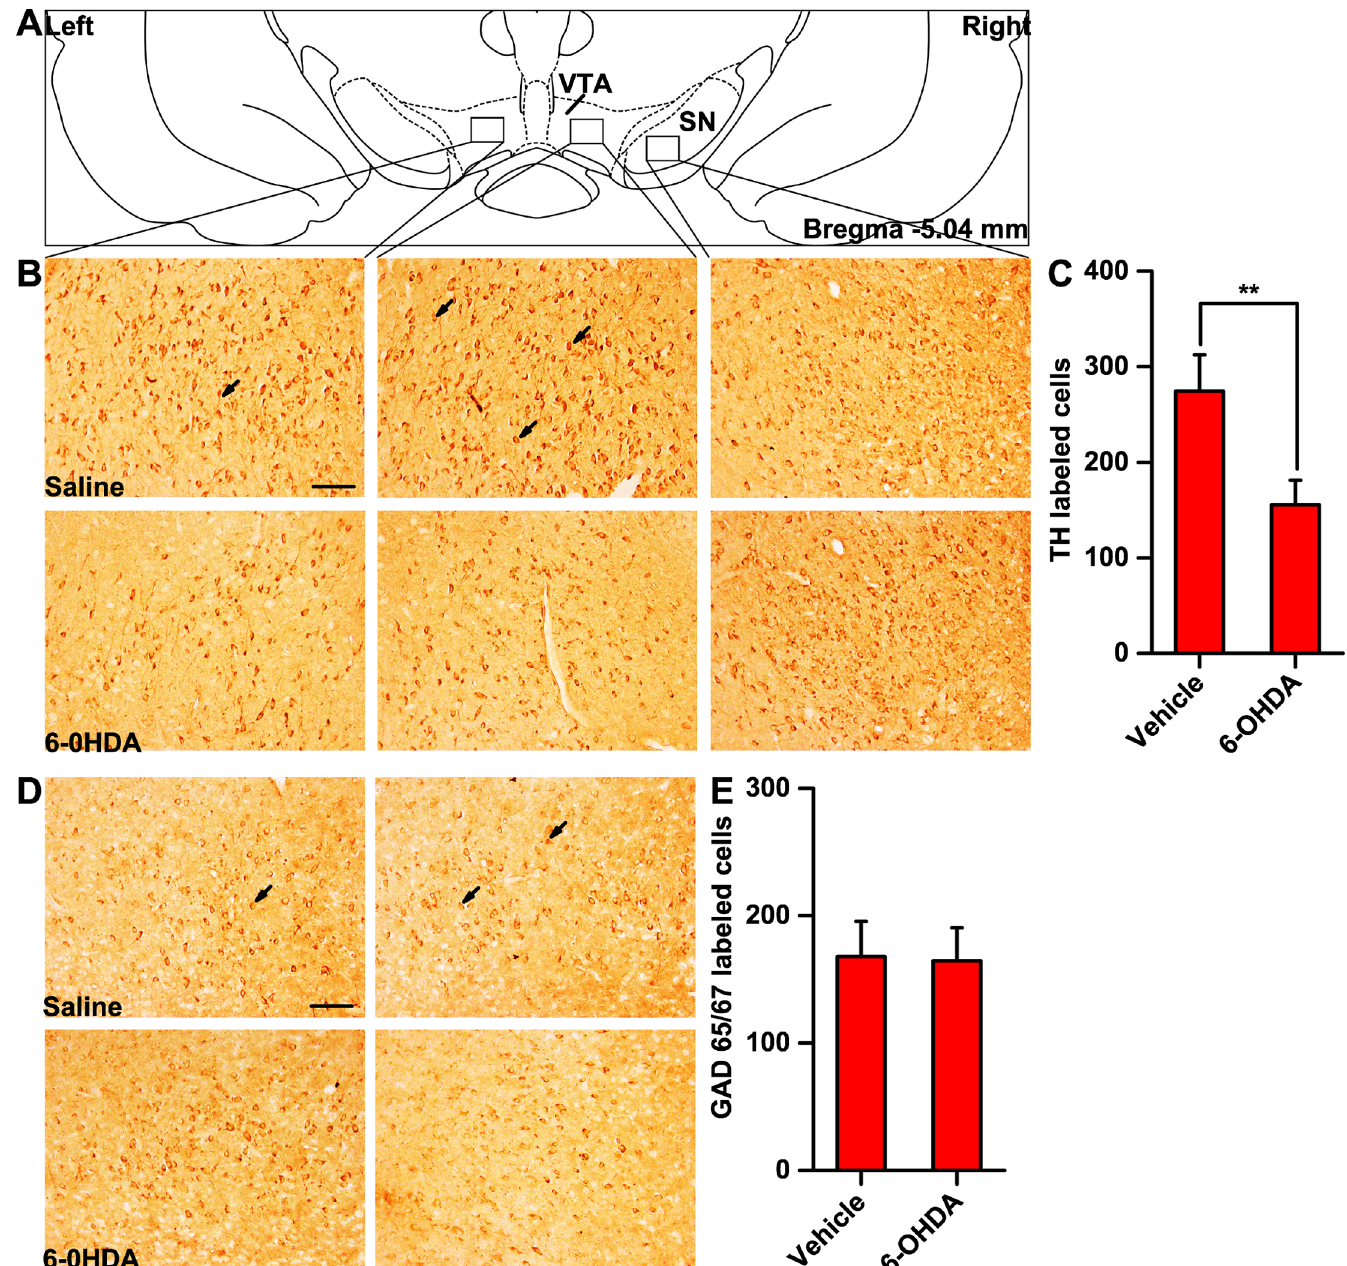
Fig 1. The effects of the bilateral infusion of 6-OHDA into the VTA on the number of dopaminergic neurons in the VTA and the SN (B and C) and GABAergic neurons in the VTA (D and E). 6-OHDA: 6-hydroxydopamine; VTA: ventral tegmental area; SN: substantia nigra; TH: tyrosine hydroxylase; GAD: glutamic acid decarboxylase. ** p < 0.01 vs . vehicle; n = 22 for the vehicle group and n = 24 for the 6-OHDA group. Scale bar = 100 μ